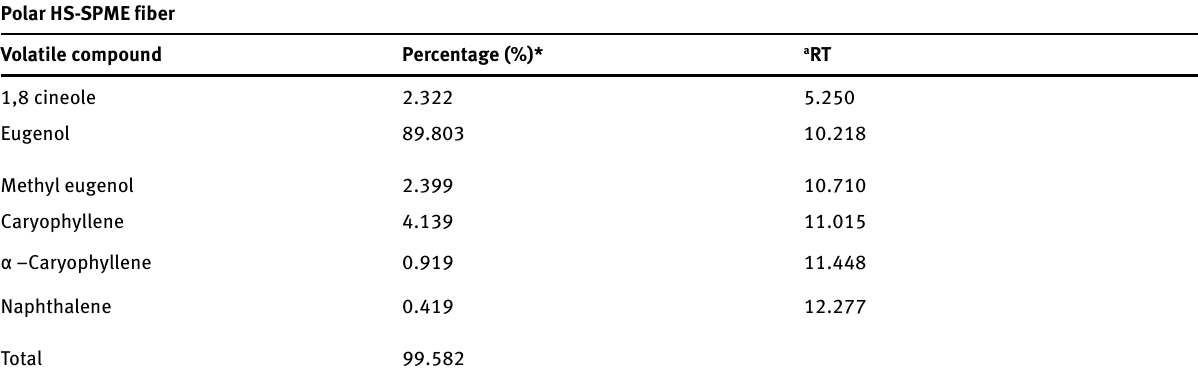
Table 4: Solid- Phase Microextraction of P. dioica leaf oil with Polar SPME